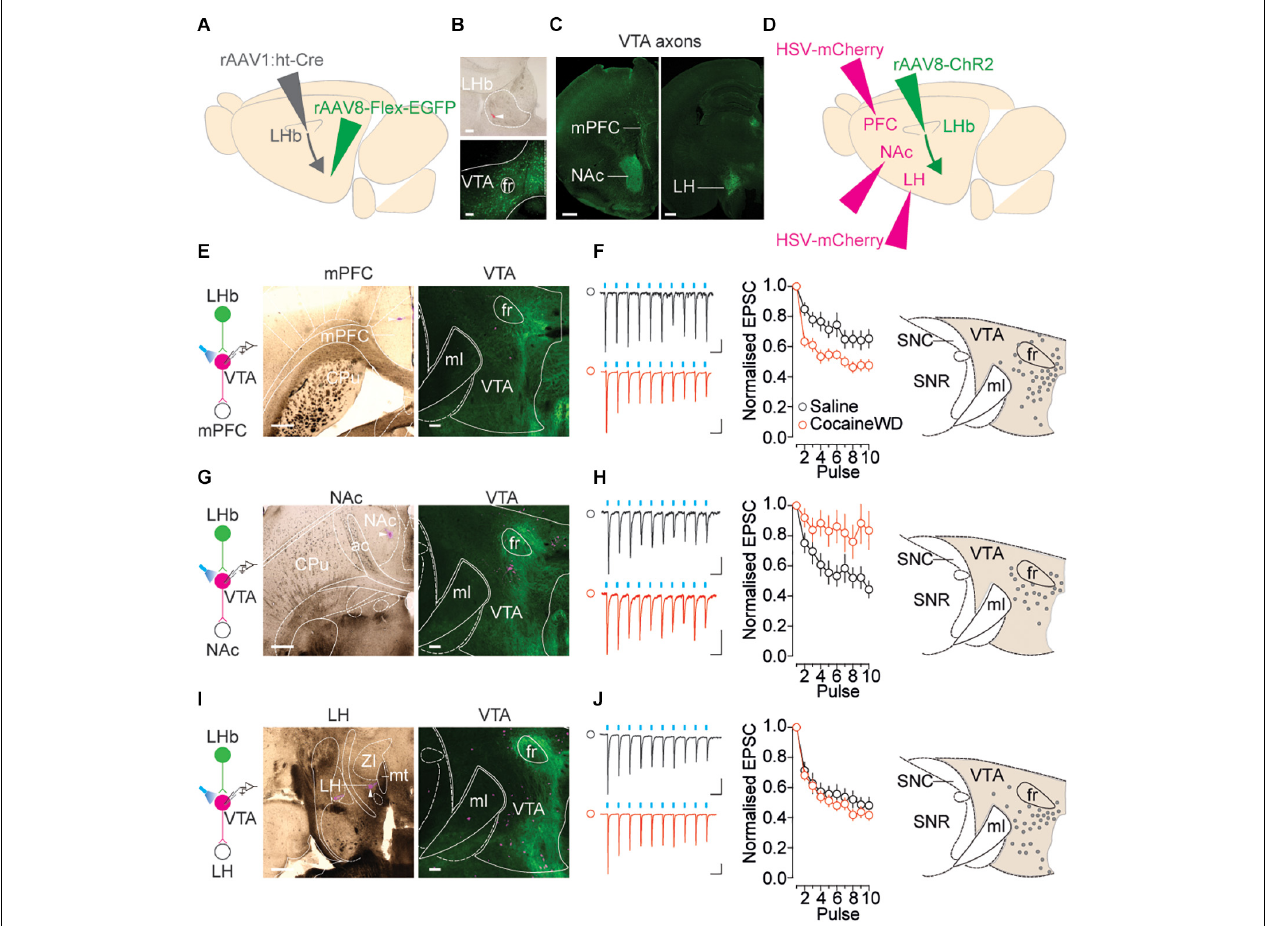
FIGURE 3 | Cocaine withdrawal re-shapes glutamatergic transmission at LHb-to-VTA output circuits. (A) Left: Viral strategy to visualize projection targets of LHb-receiving VTA neurons. Right: Respective terminal fields in mPFC, NAc, and LH. (B) Top: Site of rAAV1:ht-Cre in the LHb (tip of injection needle indicated by white arrow and small deposit of red retrobeads). Bottom: LHb-receiving, GFP positive neurons in the VTA following rAAV8-Flex-GFP injection (both coronal plane, 100 µ m, 10 × ). (C) Terminal zones of axonal projections of LHb receiving VTA neurons (both coronal plane, 500 µ m, 2.5 × ). (D) Viral strategy to interrogate LHb innervation of output specific VTA populations. (E) Left: HSV-mCherry injection site in mPFC. Right: Overlapping LHb terminals (GFP) with retrogradely labeled VTA-to-mPFC neurons. (F) Left: Sample traces (Saline: 50 ms, 20 pA; Cocaine: 50 ms, 100 pA) and normalized EPSC vs. pulse plots (saline n cells / mice = 21/16; cocaine n cells / mice = 21/16) Interaction factor F (9,378) = 4.535, P < 0.0001 two-way ANOVA Repeated Measures. Right: map of recorded VTA-to-mPFC cells. (G) Left: HSV-mCherry injection site in NAc. Right: Overlapping LHb terminals with retrogradely labeled VTA-to-NAc neurons. (H) Left: Sample traces (Saline: 50 ms, 20 pA; Cocaine: 50 ms, 20 pA) and normalized EPSC vs. pulse plots (saline n cells / mice = 11/5; cocaine n cells / mice = 13/3) Interaction factor F (9,198) = 2.953, P = 0.0026 two-way ANOVA Repeated Measures. Right: map of recorded VTA-to-NAc cells. (I) Left: HSV-mCherry injection site in LH. Right: Overlapping